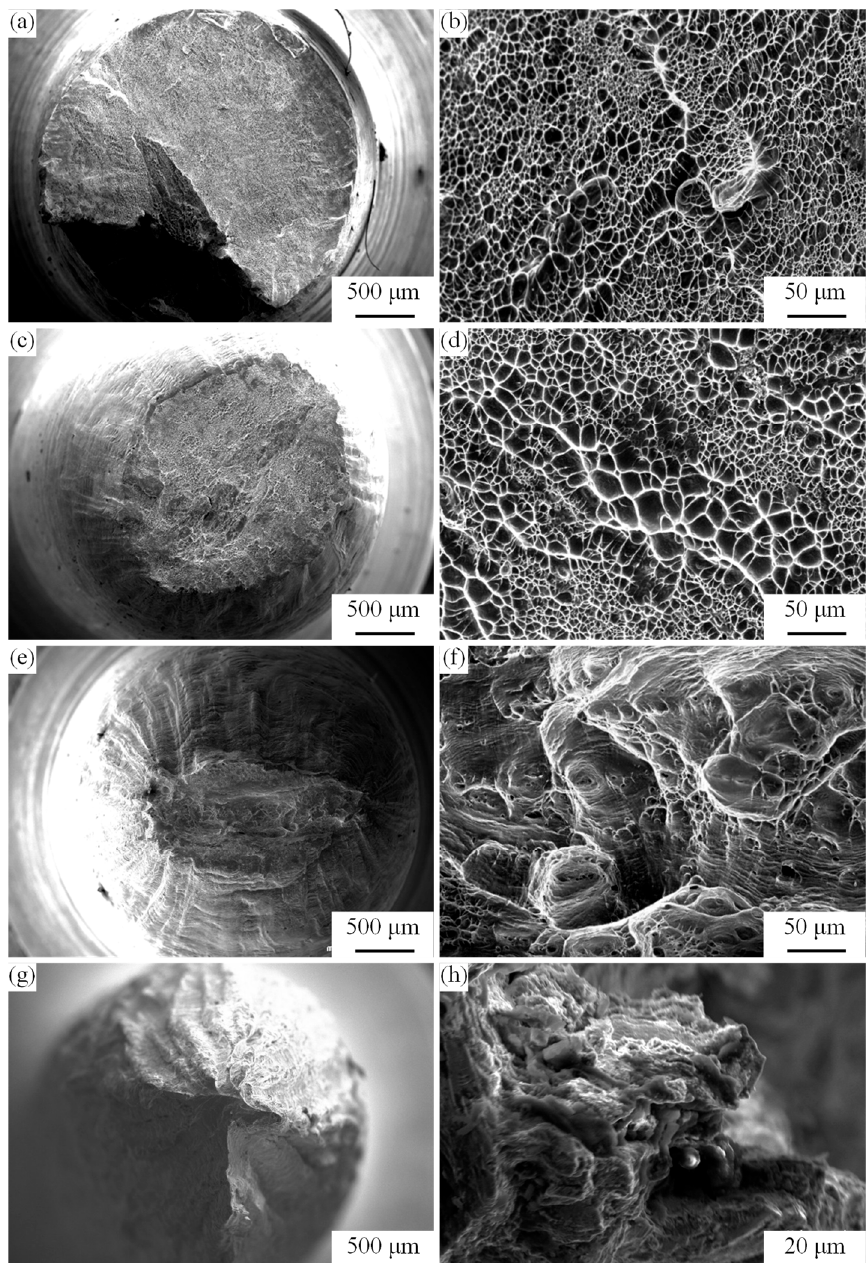
Figure 7. SEM images of the tensile fracture surfaces of 2Zr-1.2O alloy at different temperatures: ( a , b ) − 196 °C; ( c , d ) 19 °C; ( e , f ) 250 °C; ( g , h ) 750 °C. ( a , c , e , g ) The entire fracture surfaces; ( b , d , f , h ) the ( a , b ) − 196 ◦ C; ( c , d ) 19 ◦ C; ( e , f ) 250 ◦ C; ( g , h ) 750 ◦ C. ( a , c , e , g ) The entire fracture surfaces; ( b , d , f , h ) the enlarged images of fracture surfaces. enlarged images of fracture